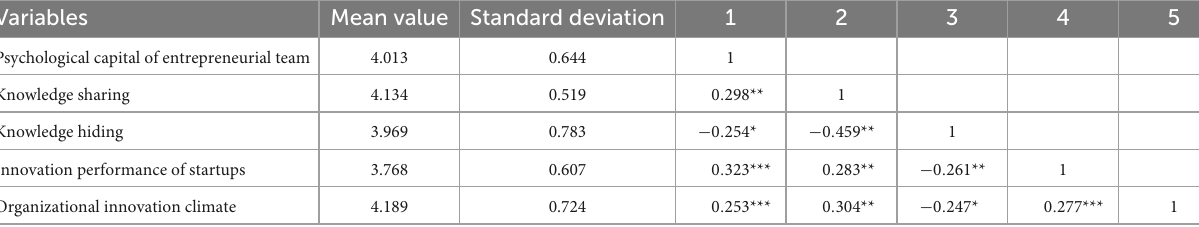
TABLE 3 Descriptive statistical analysis and correlation